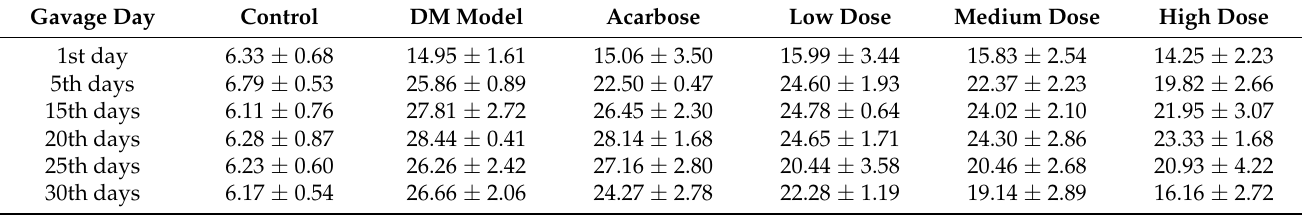
Table 1. Summary sheet of FBG of diabetic rats treated by DC-5 and acarbose for 30 days (Mean ± SD,